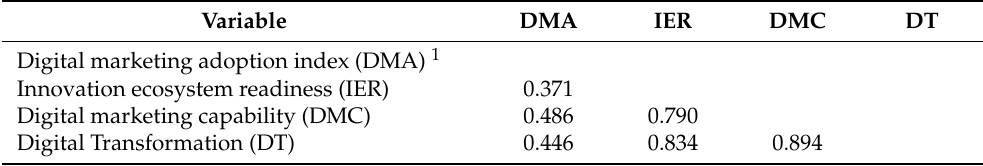
Table 4. Heterotrait-Monotrait Ratio